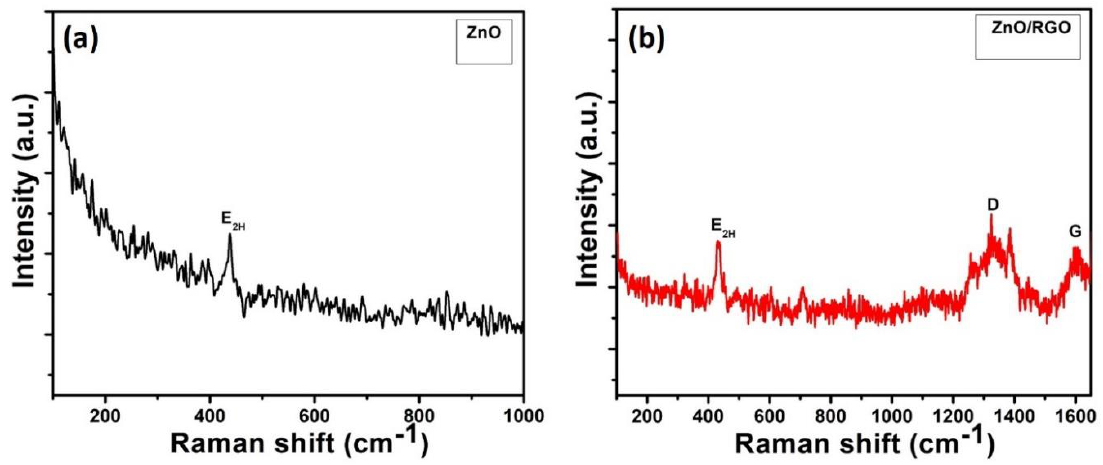
Figure 4. Raman spectra of ( a ) ZnO and ( b ) ZnO/RGO nanocomposites.